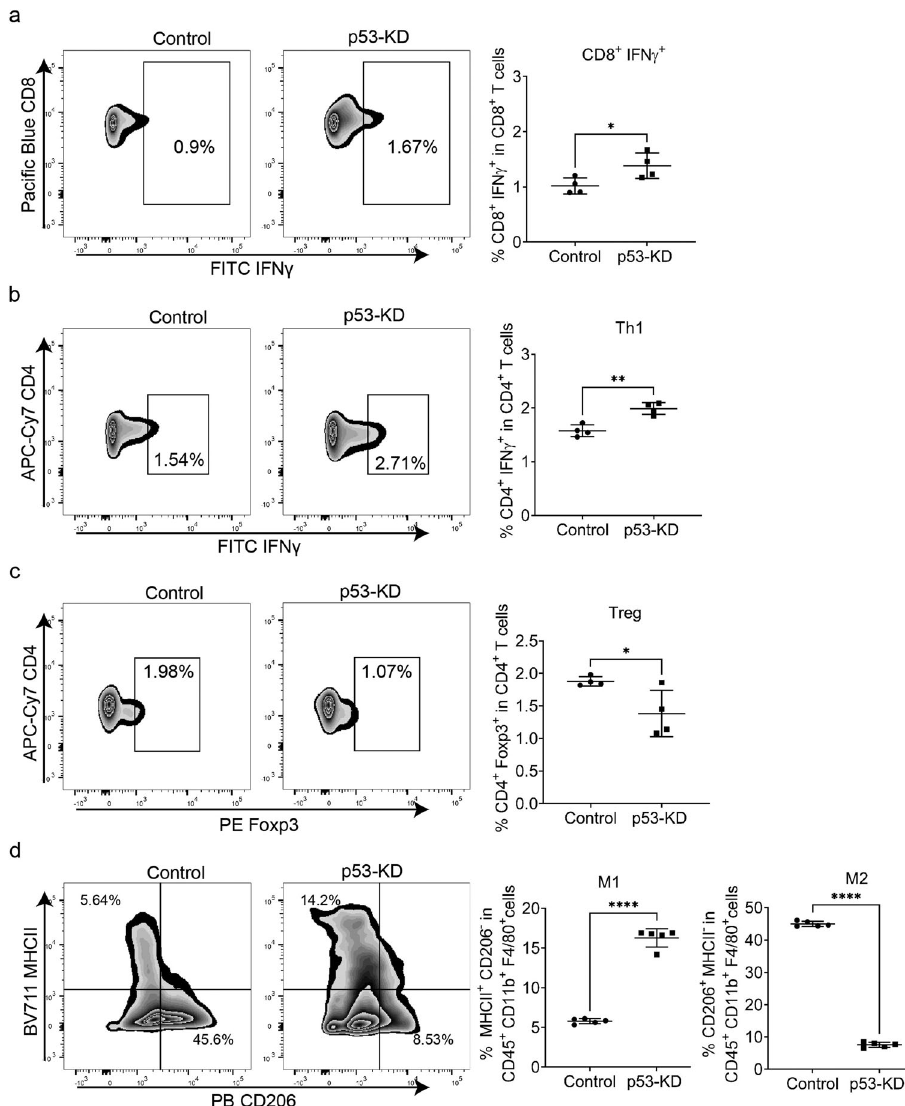
Fig. 5 Flow cytometry of immune populations regulated by ROC1 control tumor- and ROC1 p53-KD tumor-conditioned medium. Comparison of the frequencies of IFN γ + CD8 + T cells ( a ); IFN γ + CD4 + T cells (Th1 cells; b ); and FOXP3 + CD4 + (Tregs; c ) in splenocytes cultured in the presence of ROC1 control tumor- or ROC1 p53-KD tumor-conditioned media. d Comparison of the frequencies of MHCII + CD206 − (M1-type) and MHCII-CD206 + (M2- type) macrophages in bone marrow precursor cells cultured in the presence of control tumor- or p53-KD tumor-conditioned medium. Dots represent individual sample ( n = 4 – 5, error bars = standard deviation). Unpaired two-tailed Student ’ s t test p -values shown, * p < 0.05, ** p < 0.001, **** p <